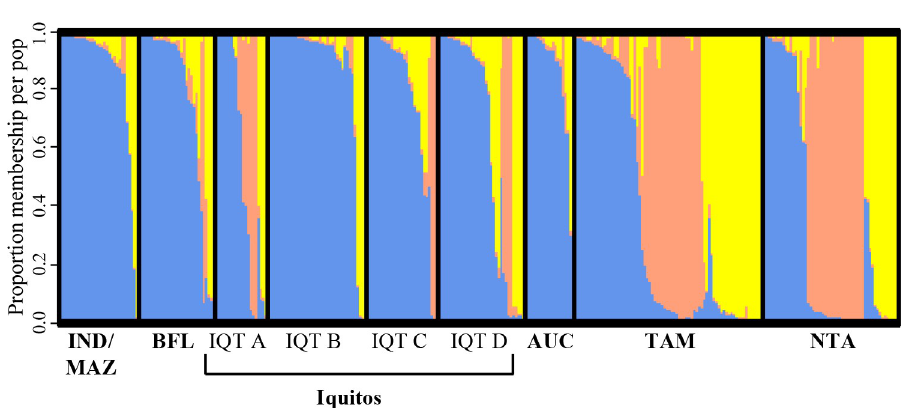
Fig 3. Structure diagram indicating the distribution of K = 3 genetic clusters across sampling locations. Individual mosquitoes are indicated by vertical bars and color denotes genetic group membership. The most likely number of populations were identified as being k = 3 different genetic groups. While the dominance of one genetic group (depicted in blue) in Iquitos B (IQTB), Indiana/Mazan (INDM), Aucayo (AUC), and Barrio Florida (BFL) indicates some genetic isolation at these sites, other sampling locations contain individuals from various genetic